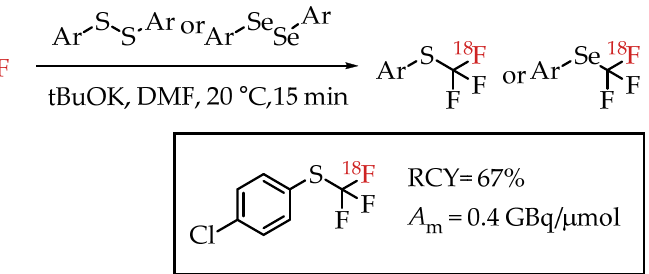
mice scanned at 45, 60 and 75 min after injection of S -[ 18 F]CF 3 D CYS and 60 min after injection of [ 18 F]FDG (the white